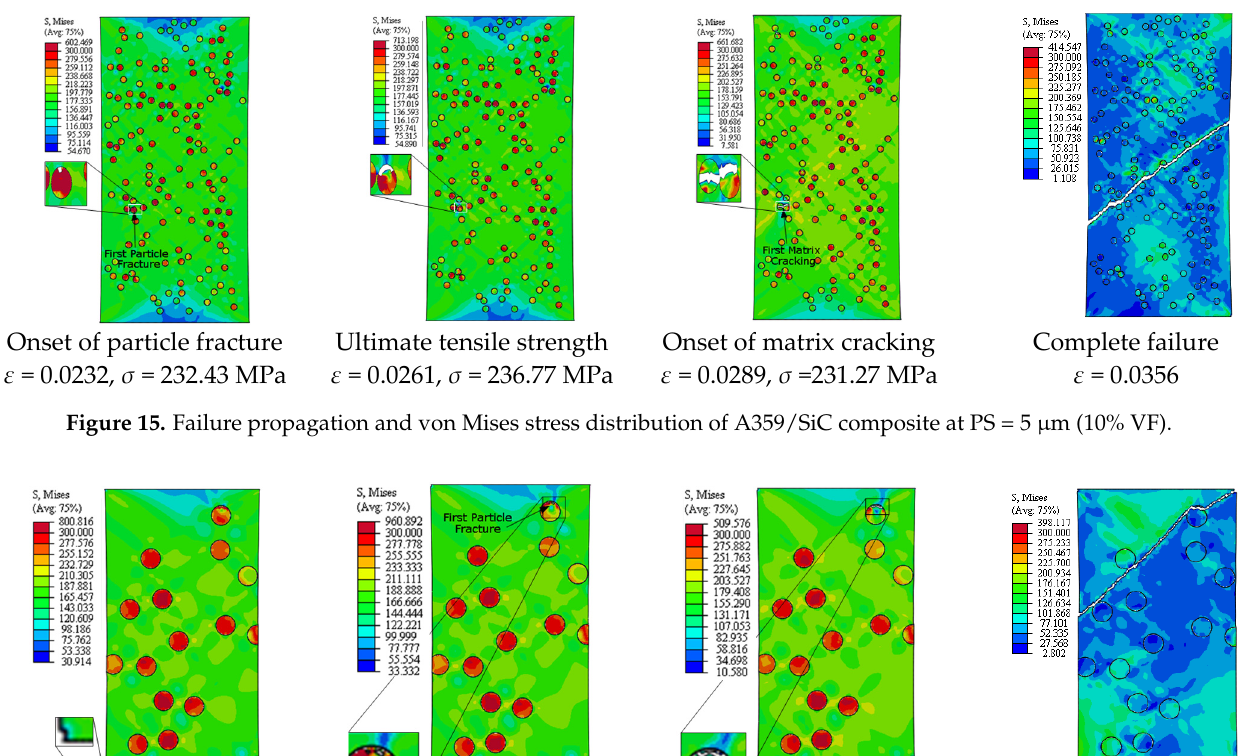
Figure 17. Failure propagation and von Mises stress distribution of A359/SiC composite at PS = 20 µm (10% VF).